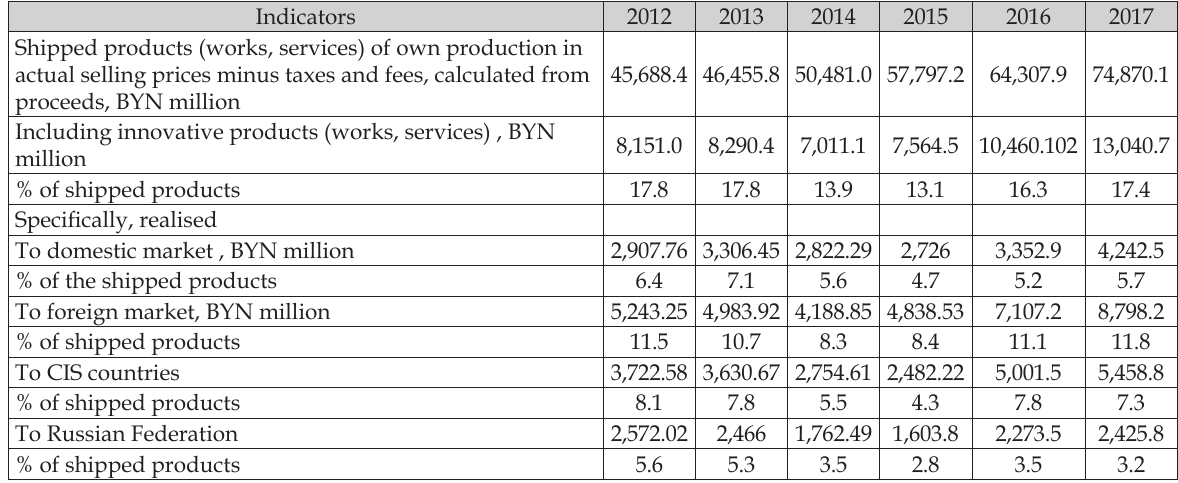
Table 5. Shipped and innovative industrial products of the Republic of Belarus.